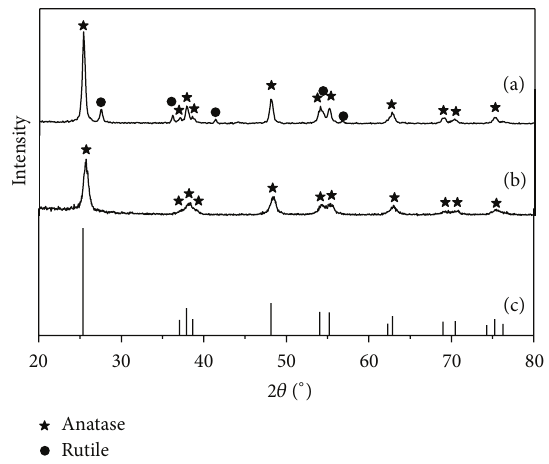
Figure 1: Characteristic XRD pattern of (a) P25; (b) the prepared hierarchical TiO 2 nanotubes sample; and (c) JCPDF card number 73-1764 of anatase TiO 2